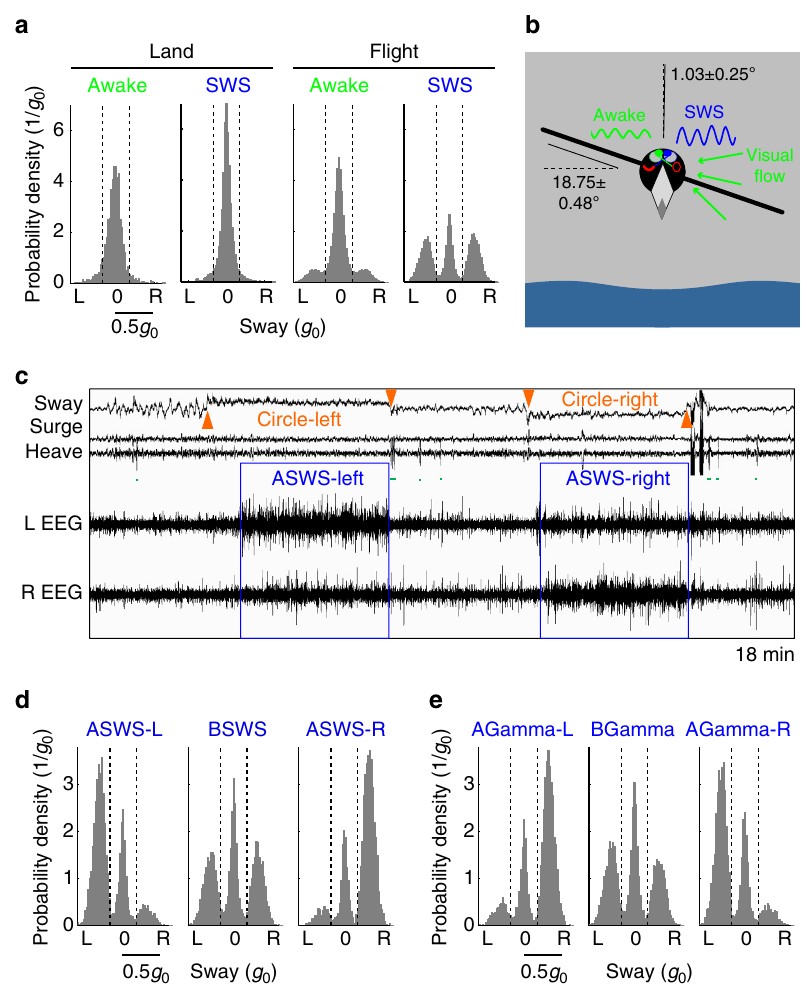
Figure 3 | Slow wave sleep electroencephalogram (EEG) asymmetry is related to circling flight. ( a ) Distribution of awake and SWS 4s epochs (all birds combined) occurring at different sway accelerations (0.02 g 0 bins) on land and in flight at night. On land (top), the values were clustered around zero while awake and in SWS indicating that the birds held their head straight during both states. Although the birds also held their head and wings straight while awake in flight, SWS, in most cases (70.57%), occurred with circling flight to the left and right, as reflected by sway acceleration o (cid:2) 0.175 g 0 and 4 0.175 g 0 (dashed vertical lines). ( b ) Diagram showing the wing and head angle relative to the horizon during circling flight to the left calculated from the accelerometry. The corresponding brain state (see below) is also shown. ( c ) Recording showing the relationship between asymmetric SWS (ASWS) and acceleration along the sway axis; during ASWS with greater EEG slow wave activity (SWA; 0.75–4.5Hz power) in the left hemisphere (ASWS-L) the sway axis showed high values corresponding to circling to the left, and when SWA was greater in the right hemisphere (ASWS-R), the sway axis showed low values corresponding to circling to the right. Same bird as in Fig. 2. ( d ) The relationship between sway acceleration and type of SWS in flight for all birds combined. Data from ( a ) are partitioned according to the type of SWS as defined in the main text; ASWS-L, ASWS-R and bihemispheric SWS (BSWS). ( e ) Relationship between flight mode (sway acceleration) and SWS in flight for data from ( a ) partitioned according to the interhemispheric asymmetry in gamma activity (30–80Hz power); asymmetric gamma with greater gamma in the left (AGamma-L; AI Z 0.1) or right (AGamma-R; AI r (cid:2) 0.1) hemisphere and bihemispheric (symmetric) gamma (BGamma; (cid:2) 0.1 o AI o 0.1). The overall relationship between circling flight, brain state and probable eye state 18 is summarized in ( b ); awake hyperpallium (green) and sleeping hyperpallium (blue) and the corresponding relative difference in EEG SWA. The green arrows show the general direction of visual flow while circling to the